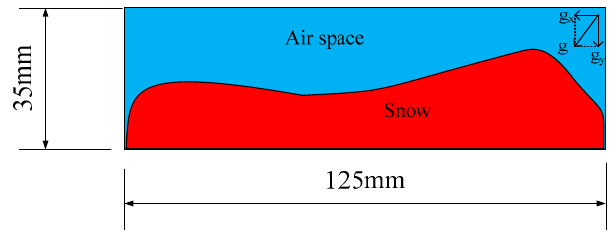
Figure 15. Relationship of Reynolds numbers in each cross section.